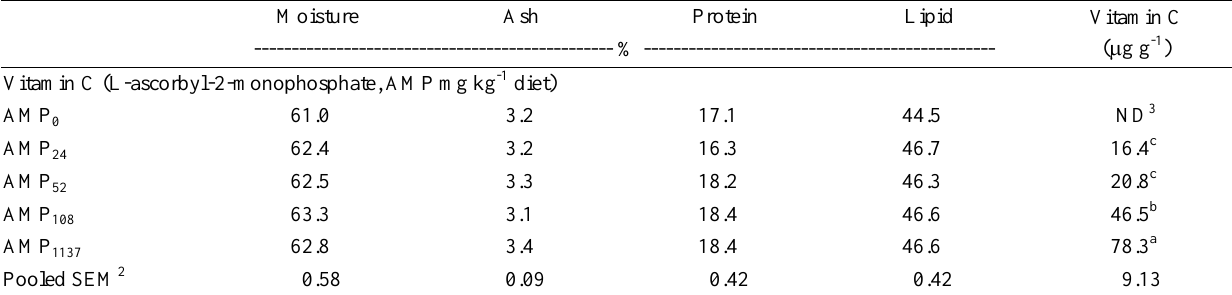
Table 3. Whole-body proximate composition and vitamin C concentrations of juvenile eel, Anguilla japonica , fed experimental diets for 12 wk 1